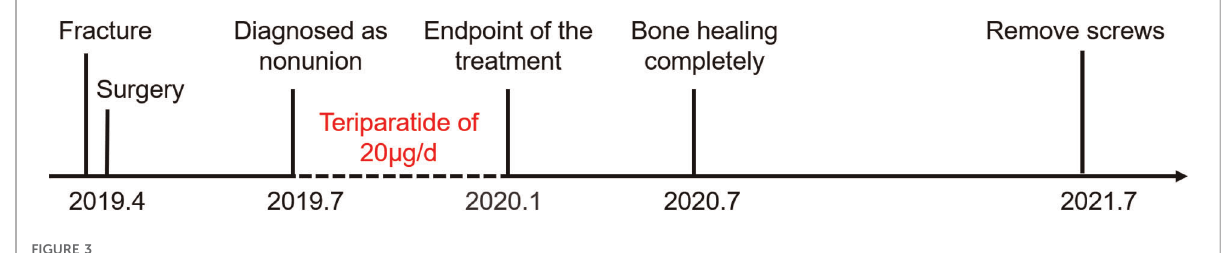
FIGURE 3 The treatment timeline of this